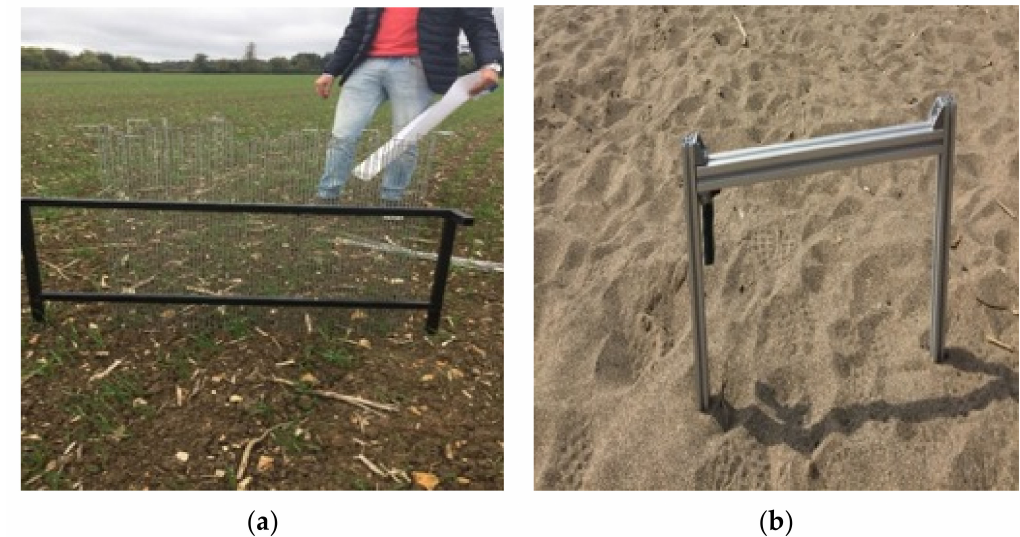
Figure 7. The process of surface roughness parameters measurement using a needle profilometer ( a ) and a laser profilome- ter ( b